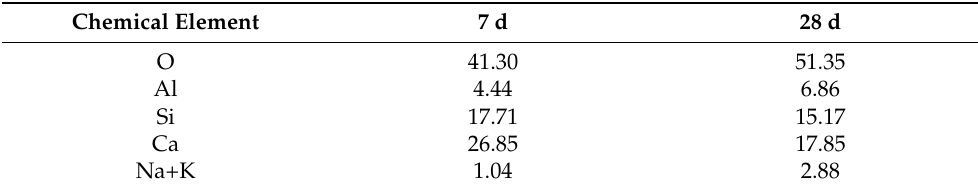
Table 4. EDS analysis results of C-A-S-H gel (atomic percentage/%).